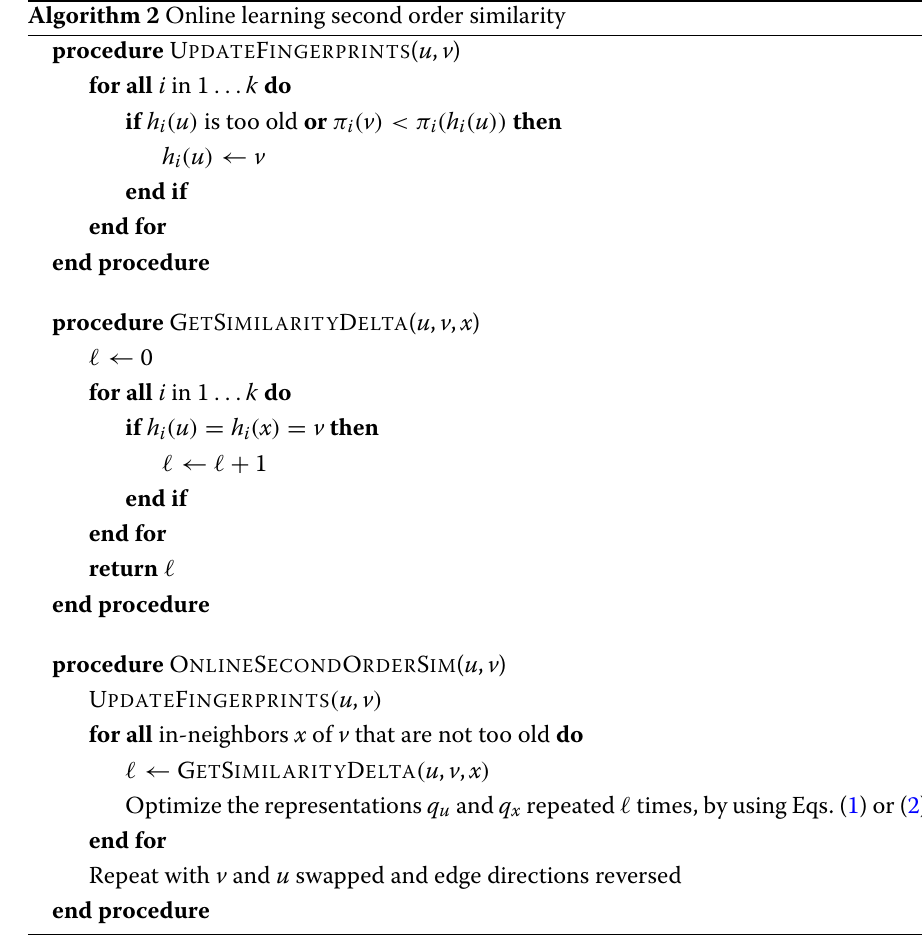
Algorithm for online learning second order